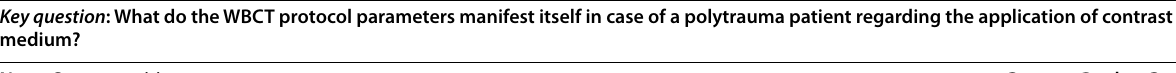
Table 14 Section 6: Whole Body CT – Protocol, key issue 5: Injection of Contrast